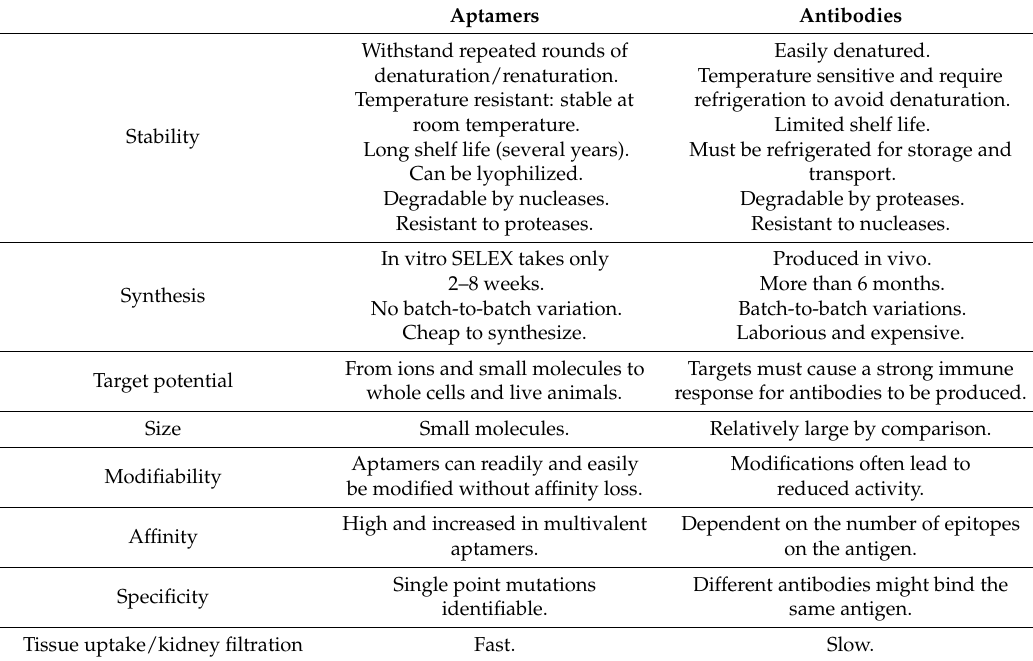
Table 1. Comparison between aptamers and antibodies. A comparison of critical features of aptamers shows how aptamers can supplement monoclonal